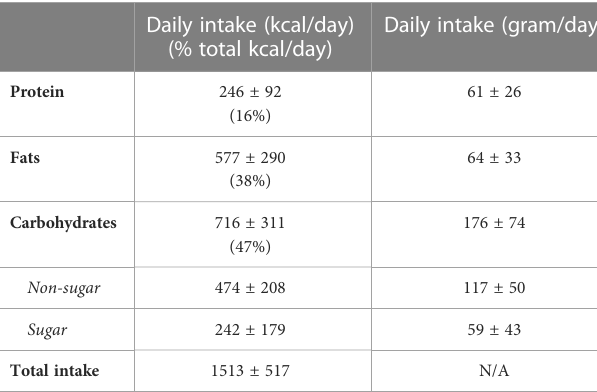
TABLE 3 Nutritional intake: Average values of nutrients intake reported by random subsample of 34 participants that maintained dietary records.